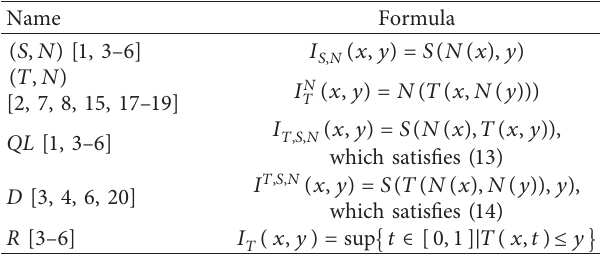
Table 4: Known families of fuzzy implications.